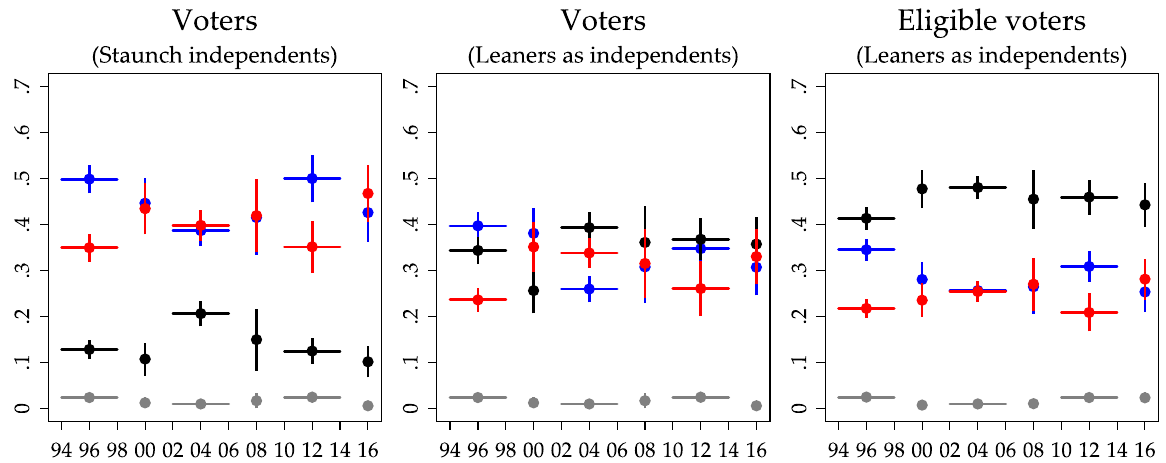
Figure 4: Class VI trends in identification with the Democratic Party (blue), Republican Party (red), another party (gray), and independent